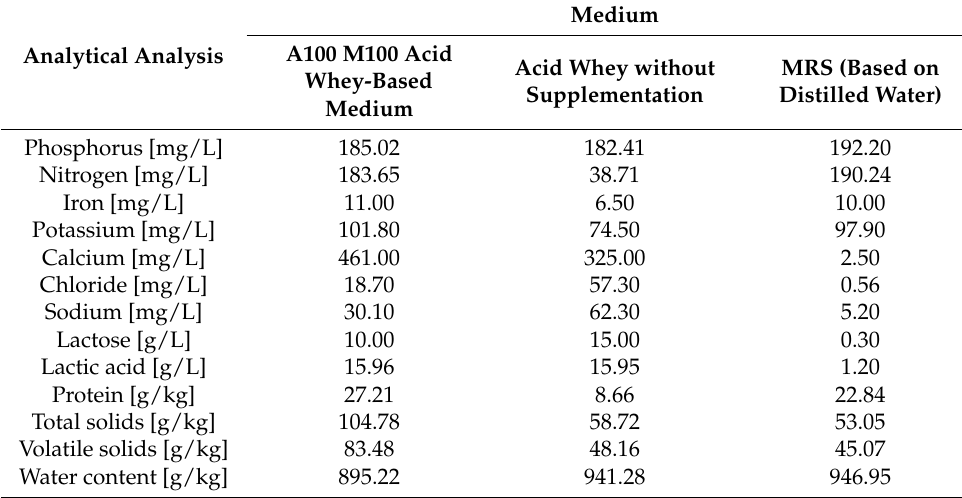
Table 3. Characteristics of acid whey-based medium selected for the cultivation of L. plantarum KB2 LAB